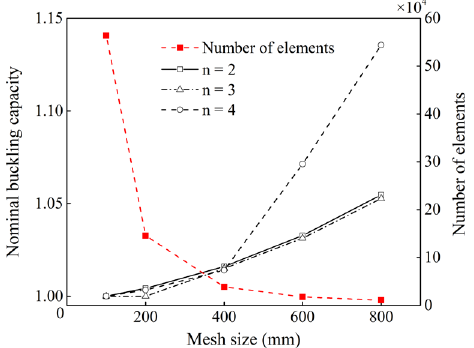
Figure 4. True stress ‐ strain curve for SPV490Q, Q345R, and Q235B. The gravity is applied with the pinned boundary condition at the bottom of the tank shell before the application of the harmonic settlement. However, the hydrostatic liquid pressure is not considered because the pressure helps stabilize the tank [13,22]. For the harmonic settlement ‐ induced deformation analysis, the bottom of the tank in the vertical direction is excited by the harmonic wave u (cid:3404) u (cid:2924) cos (cid:4666)nθ(cid:4667) , where u is settlement along the bottom of the tank, u (cid:2924) is amplitude of the n th harmonic settlement, θ is the circumferential central angle, and n is harmonic wave number. Specifically, the AnalyticalField load distribution in the Abaqus can be used to apply the harmonic settlement. Furthermore, the translations in both the radial and the circumferential directions are constrained at the bottom of the shell, and the rotation freedom is free [22,32]. The limiting settlements of the steel tank are determined for harmonic wave numbers n = 2, 3, and 4 [22,32,34]. For the wind buckling analysis, the pinned boundary condition (Ux, Uy, Uz = 0, Rotx, Roty, Rotz are free) is applied to the bottom of the FE model.